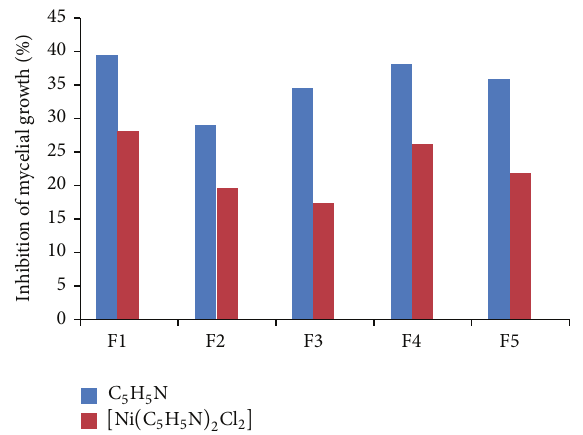
Figure 8: Inhibition of fungi mycelial growth by the tested ligand and complex.